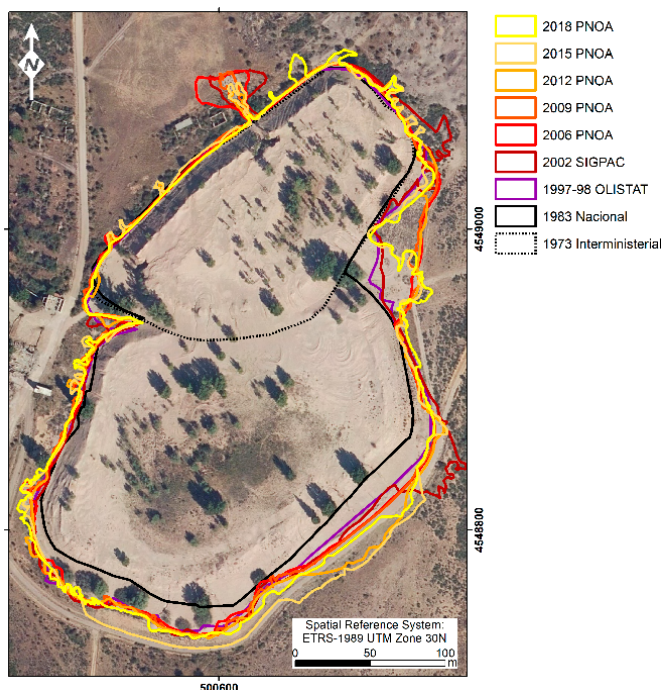
Figure 6. Sludge contours over time on the orthophoto from the 2018 flight. The mixed action of natural (surface erosion) and anthropic processes not only modifies the extent occupied by the sludge, but also determines the value of the pond slopes (Figure 7). The hillsides of the north pond had slopes greater than 60% in 2009 that had increased by 2014. In contrast, the hillsides of the south pond had slopes in the range of 30–60%, locally steepening to more than 60%, which tended to decrease. These differences, together with the greater height of the north pond compared to the south pond, may be the reason why the north pond has steep gullies on its slopes, which are connected to small valleys on the surface, while the south pond has only rills. In that period, the valleys were excavated by the ephemeral streams, the inland depressions with temporary